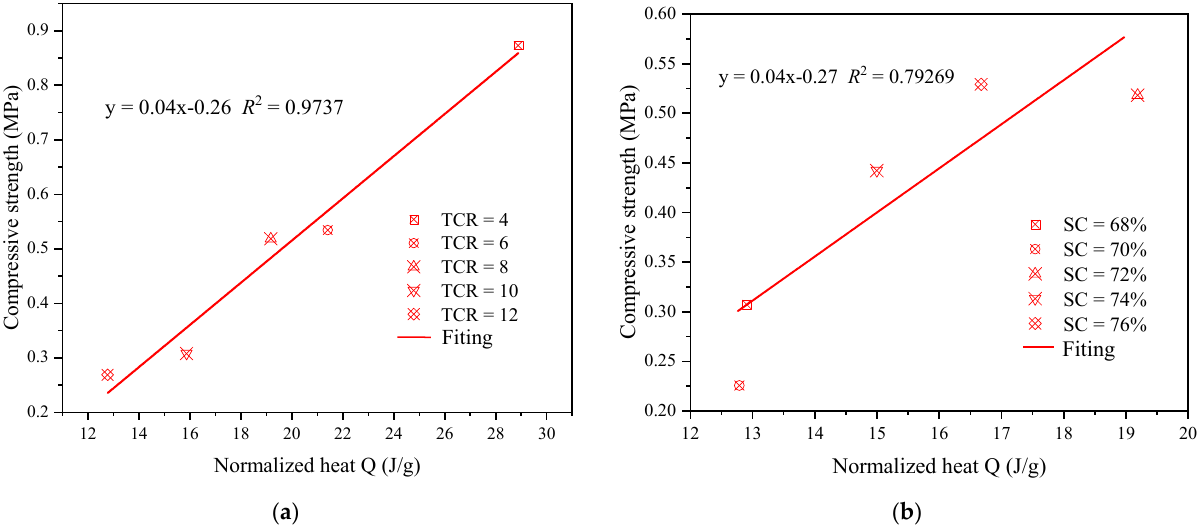
Figure 8. Hydration heat versus the compressive strength values at 3 days of CSTB: ( a ) SC = 72%; ( b ) TCR = 8.